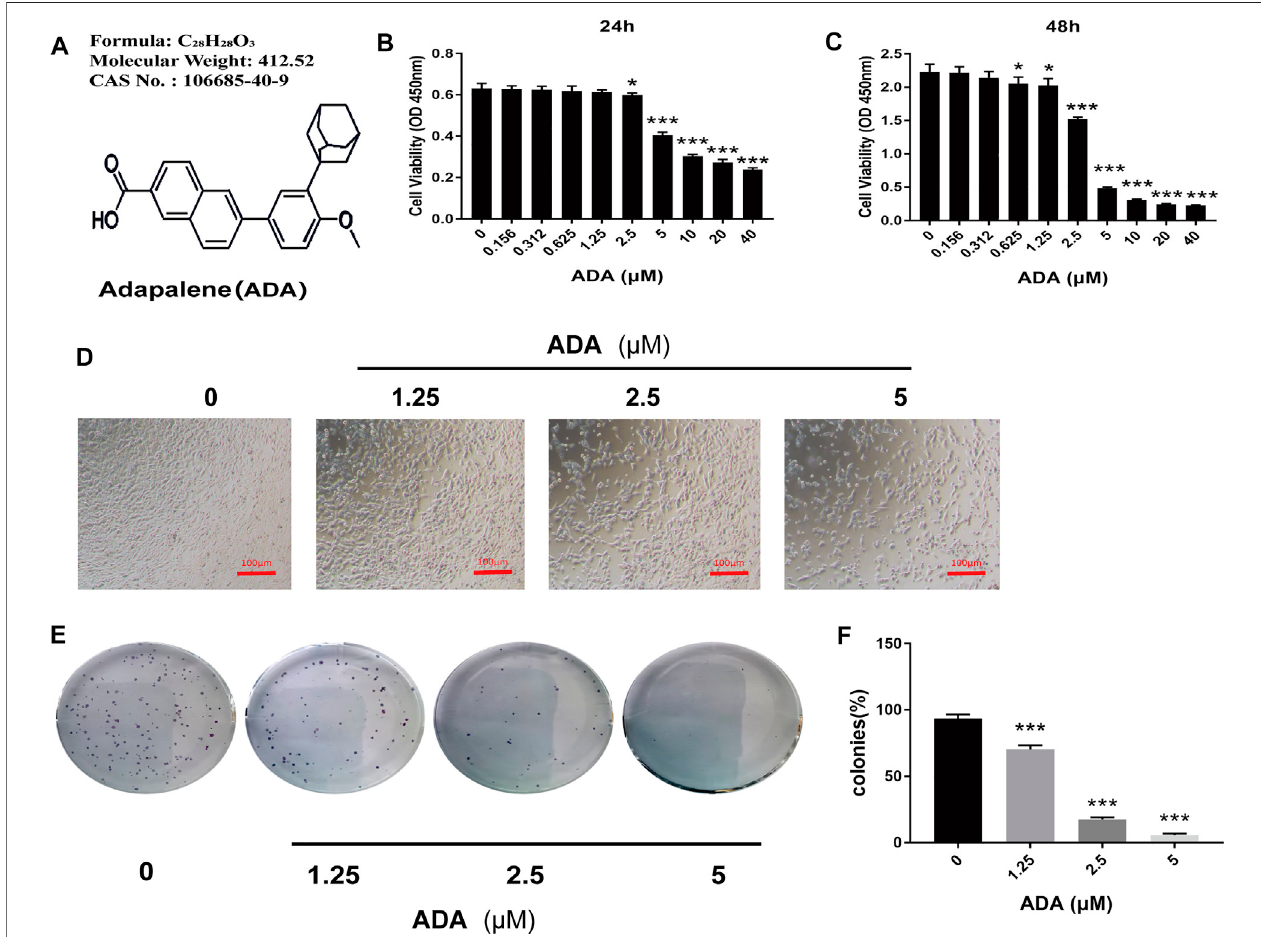
FIGURE 1 | ADA signi fi cantly suppressed the proliferation of RM-1 cells. (A) Molecular structure of ADA. (B,C) CCK8 assays were used to detect the effects of varyingADAconcentrations(0 – 40 μ M)ontheproliferationofRM-1cellsandevaluatedbyCCK8assays. (D) FollowingtreatmentofADAfor24 h,themorphologyofRM- 1cellswasvisualizedandcapturedutilizinganinvertedmicroscope(100×). (E) Thelong-termeffectsofADAinRM-1cellsweredetectedbycolonyformationassaysand the colonies were stained by 0.5% crystal violet solution and manually counted. (F) ADA signi fi cantly inhibited colony formation in a dosage-dependent way. Data are shown as mean ± standard deviation. (* p < 0.05; ** p < 0.01; *** p < 0.001 vs.